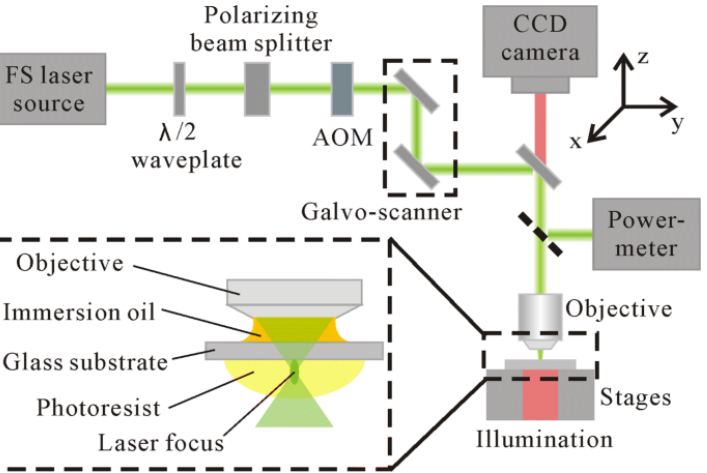
Figure 8. 2PP technology. (Reprinted from Nanoscale Research Letters , Volume 14, Lei Zheng, Kestutis Kurselis, Ayman El-Tamer, Ulf Hinze, Carsten Reinhardt, Ludger Overmeyer and Boris Chichkov, Nanofabrication of High-Resolution Periodic Structures with a Gap Size Below 100 nm by Two-Photon Polymerization, 1–9, Copyright (2019), with permission from Springer Open under the terms of